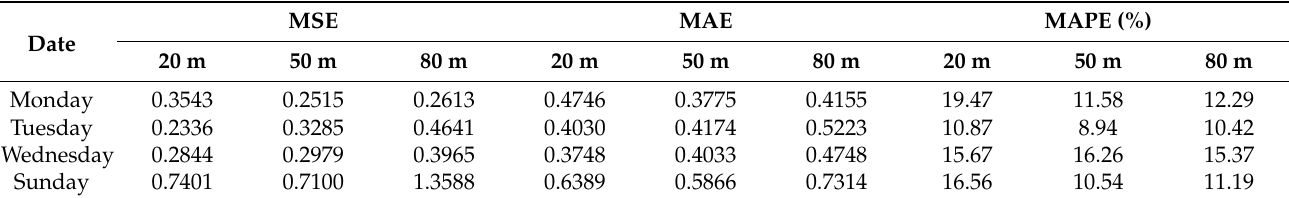
Figure 8. The bar chart for the evaluation index of the LSTM network. Table 4. The three evaluation indices of the LSTM